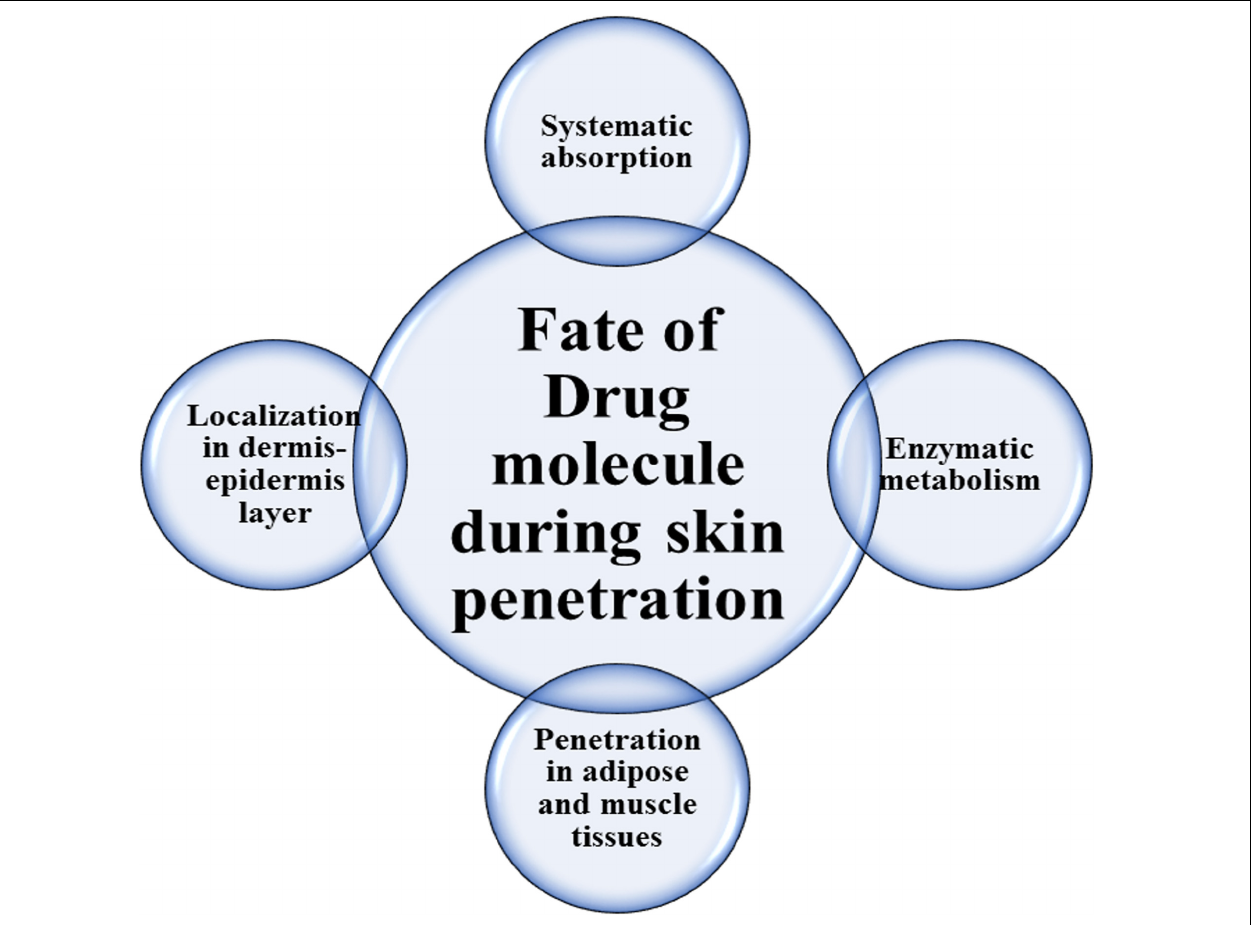
FIGURE 1 | Drug molecules’ fate during skin